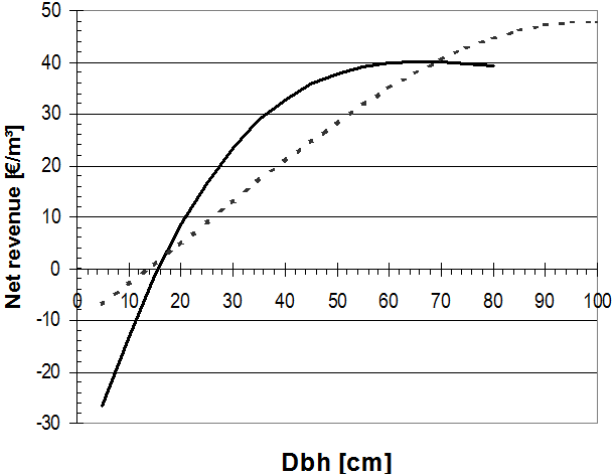
Fig. 1 . Net revenue (€/m³) as a function of dbh, for Norway spruce (solid line) and European beech (dashed line), medium-quality wood at roadside based on average values for the period 1995 to 2005 (Duncker and Zell